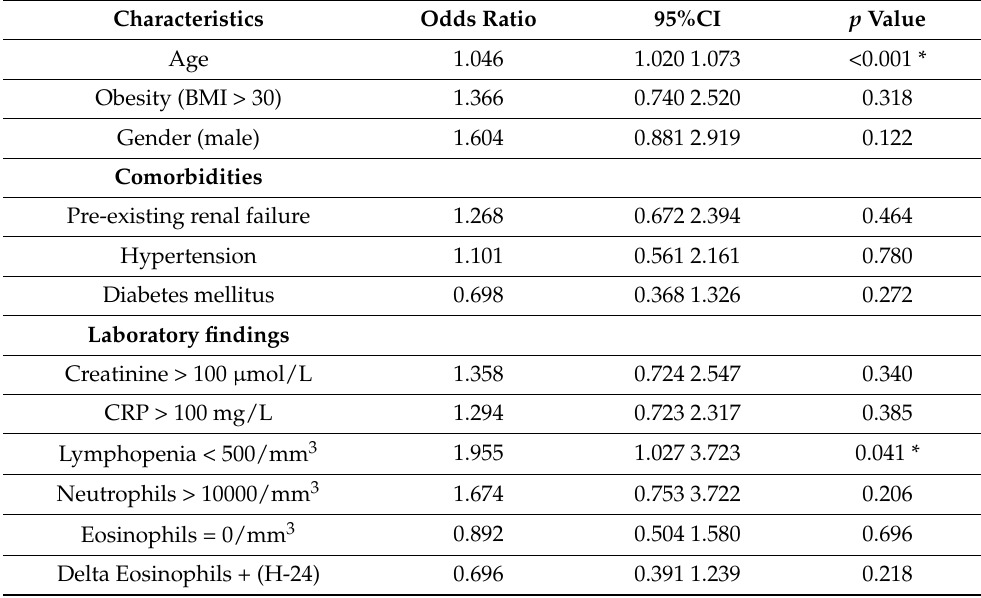
Table 4. Multivariable analysis of factors associated with in-hospital